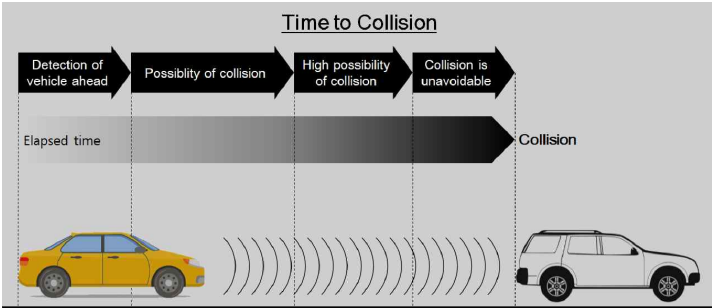
Figure 5. Schematic diagram of time to